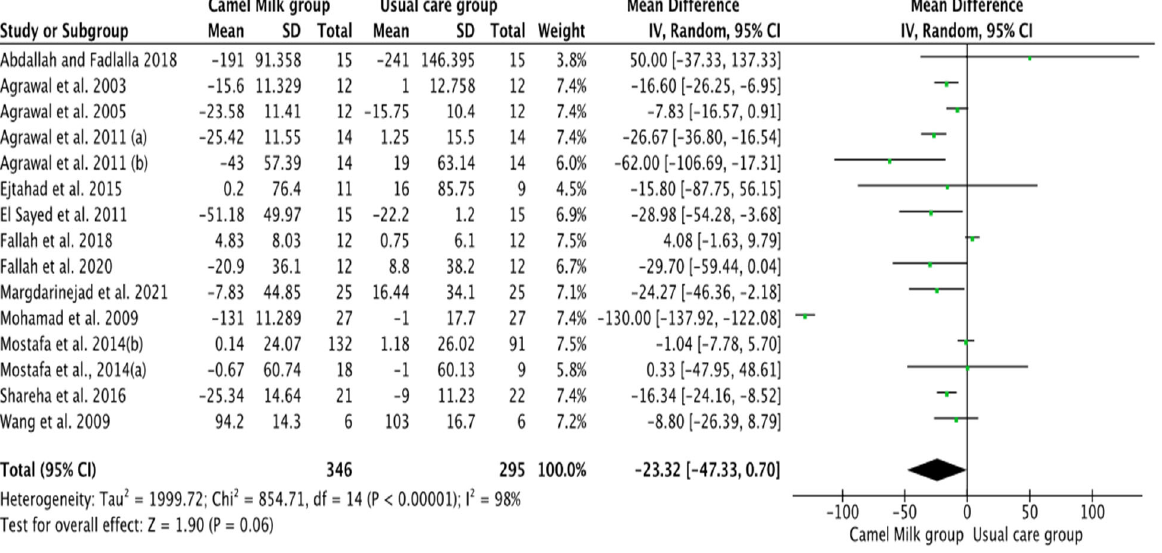
Figure 4. Forest plot for the effect of CM intake on fasting blood glucose (FBG). Note: Mostafa and Al-Musa, 2014 (a) for T1DM and (b) for T2DM.